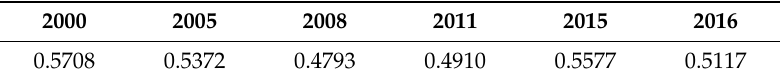
Table 3. The mean value of TVDI in the Shaanxi